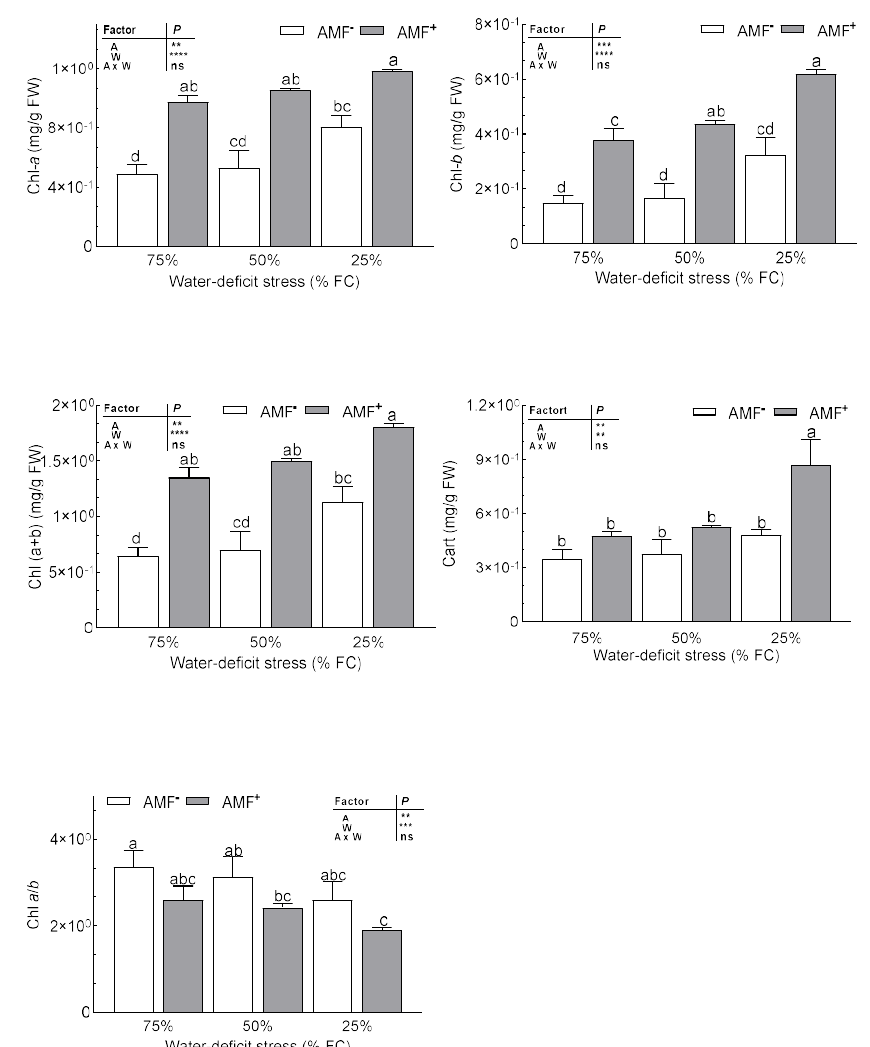
Figure 2. Chlorophyll a (Chl a ), chlorophyll b (Chl b ), total chlorophyll (Chl a + b ), carotenoids (Cart) content and chlorophyll a / b ratio (Chl a / b ) of C. spinosa seedlings’ fresh leaves cultivated without (AMF − , white bars) or with (AMF+, grey bars) native mycorrhizal fungi inoculum under three irrigation levels (% FC). The bars represent the mean ± SD of n = 6 replicates. Bars sharing a common lowercase letter reveal no significant difference according to Tukey’s post hoc test at p < 0.05. Asterisks denote the significance levels ( P ) of the effect of AMF (A), water-deficit (W) and their interaction (A × W) on each parameter measured, based on the 2-way ANOVA test: (**, p < 0.01; ***, p < 0.001; ****, p < 0.0001 and ns, no-significance p > 0.05).